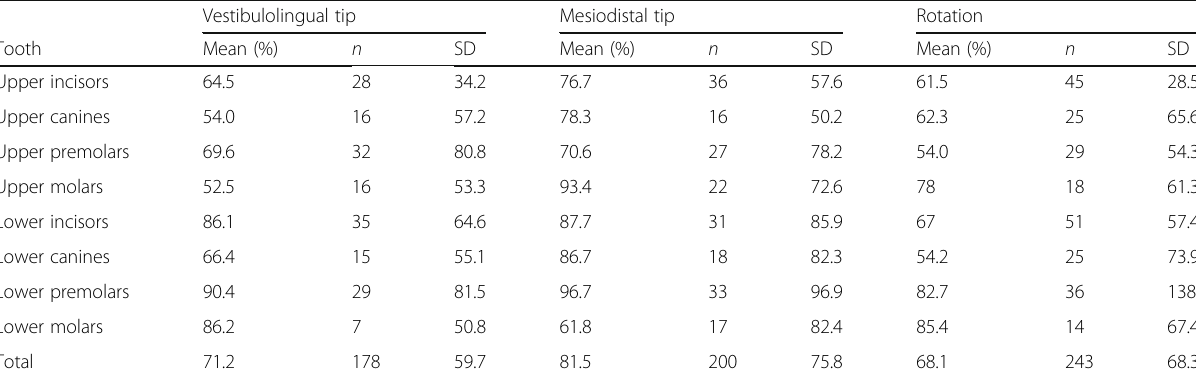
Table 6 Mean (%) accuracy of tooth movements achieved using F22 Vestibulolingual tip